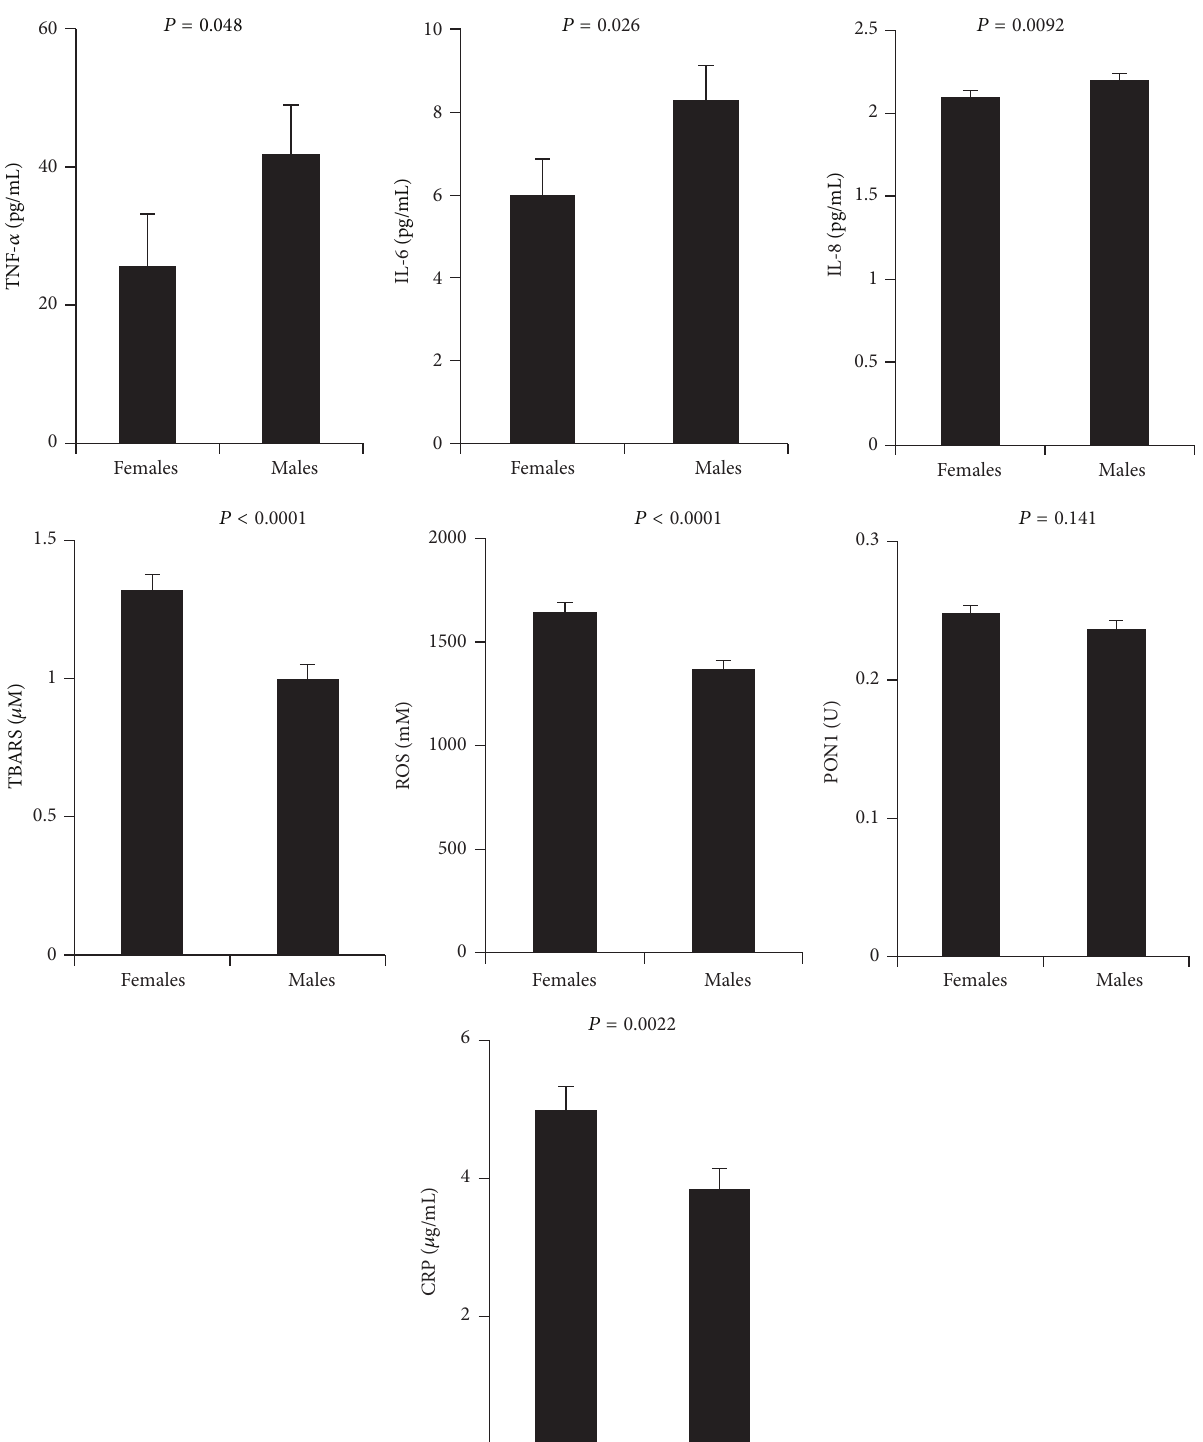
Figure 1: Least square means of TNF- 𝛼 , Il-6, IL-8, CRP, TBARs, ROS, and PON1 concentrations in plasma, for all subjects after adjusting for age, BMI, and